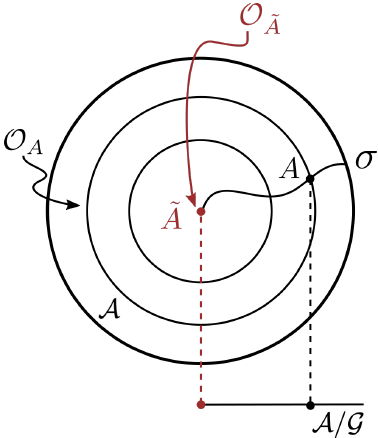
Figure 8: In this representation A is the page’s plane and the orbits are given by con- centric circles. The field A is generic, and has a generic orbit, O . The configuratoin ˜ A A has a nontrivial stabilizer group (i.e. it has non-trivial reducibility parameters), and is of a different dimension than O . The projection of ˜ A on A / G therefore its orbit O ˜ A A sits at a qualitatively different point than that of A (a lower-dimensional stratum of A / G ). Exclusion of the reducible configuration ˜ A gives rise to a fibre bundle struc- ture over A \ { ˜ A } ; here σ represents a section of A \ { ˜ A } . Whereas σ defines a slice through A , the slice through ˜ A (not depicted) is an open disk centred at ˜ A